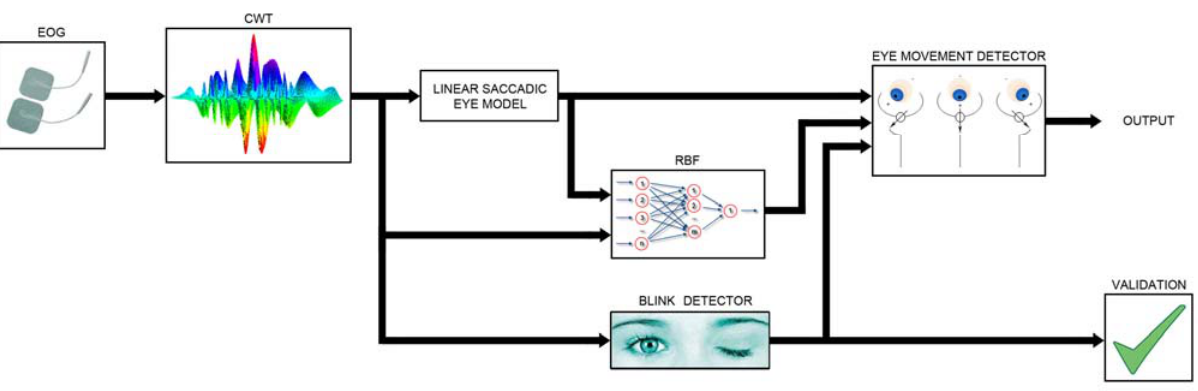
Figure 5. Saccadic eye-movement detection